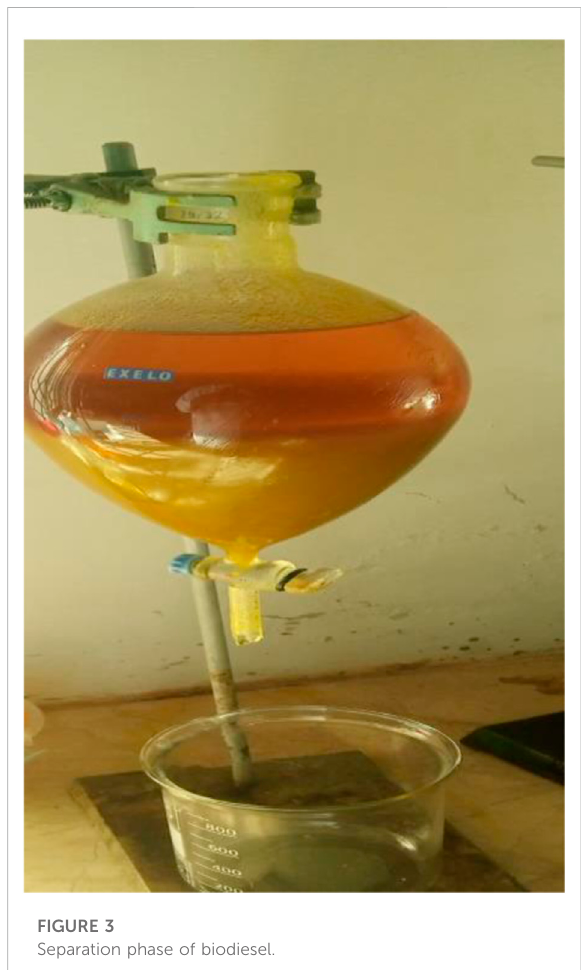
FIGURE 3 Separation phase of